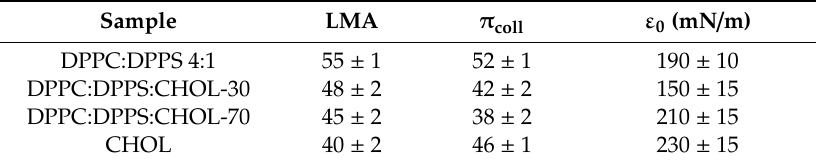
Table 3. Limiting molecular area LMA, collapse pressure ( π coll ), and maximum Gibbs elasticity ( ε 0 ) values of DPPC:DPPS:CHOL monolayers spread onto CaCl 2 5 mM (Figure 1B).